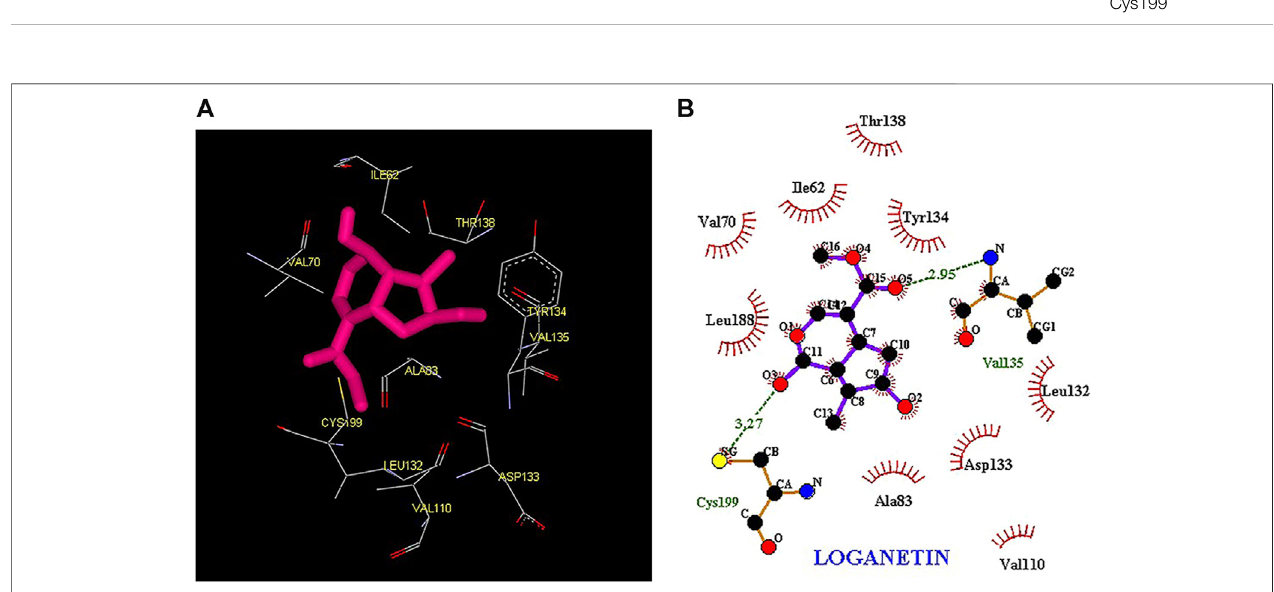
FIGURE 3 | (A) Three-dimensional view of loganetin at the GSK_3 β protein binding site. (B) Interactions of loganetin with amino acids of the GSK3_ β protein binding site.